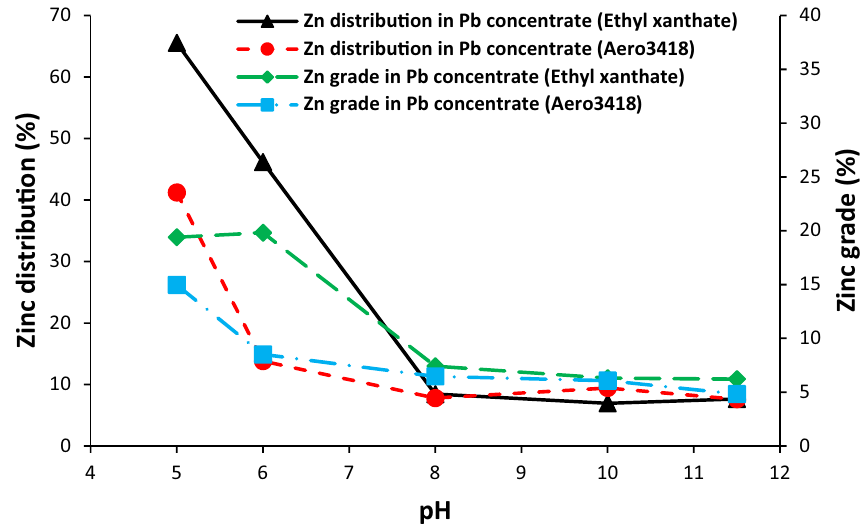
Figure 6. Effect of pH and collector type on the distribution and grade of zinc in the lead concentrate.